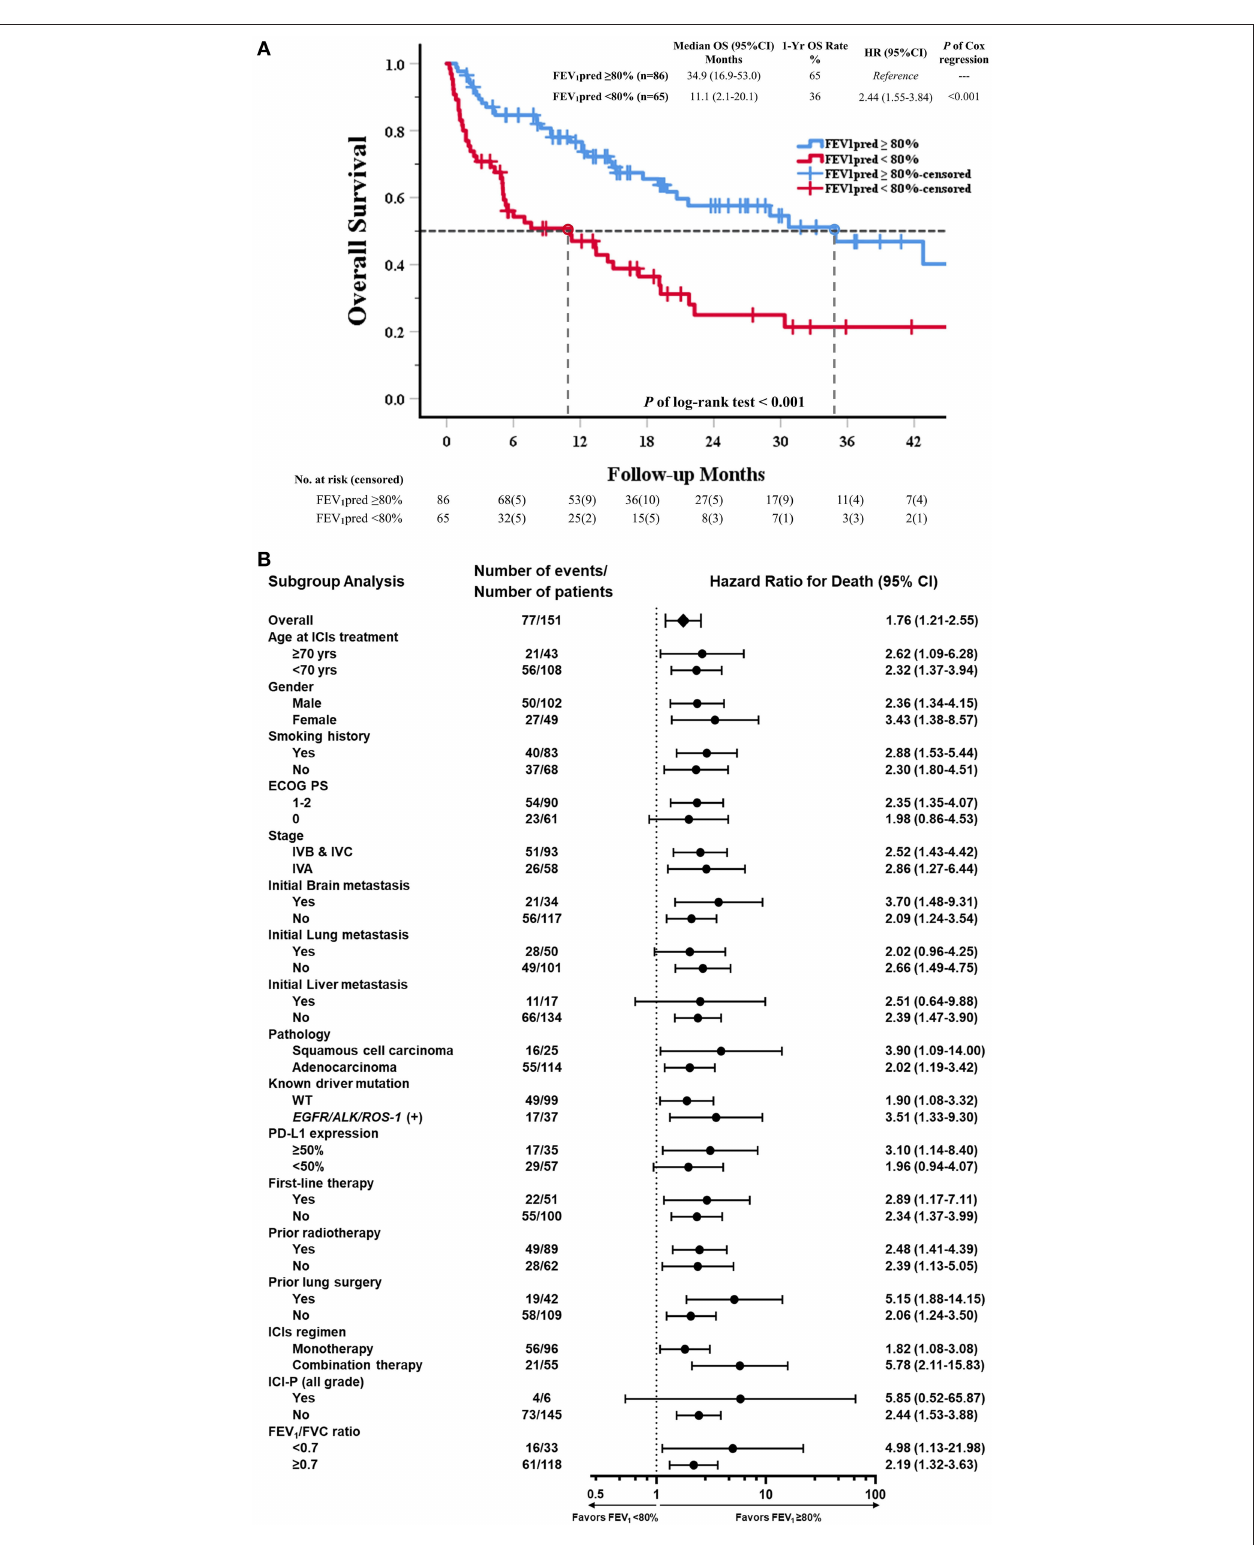
Frontiers in Medicine |